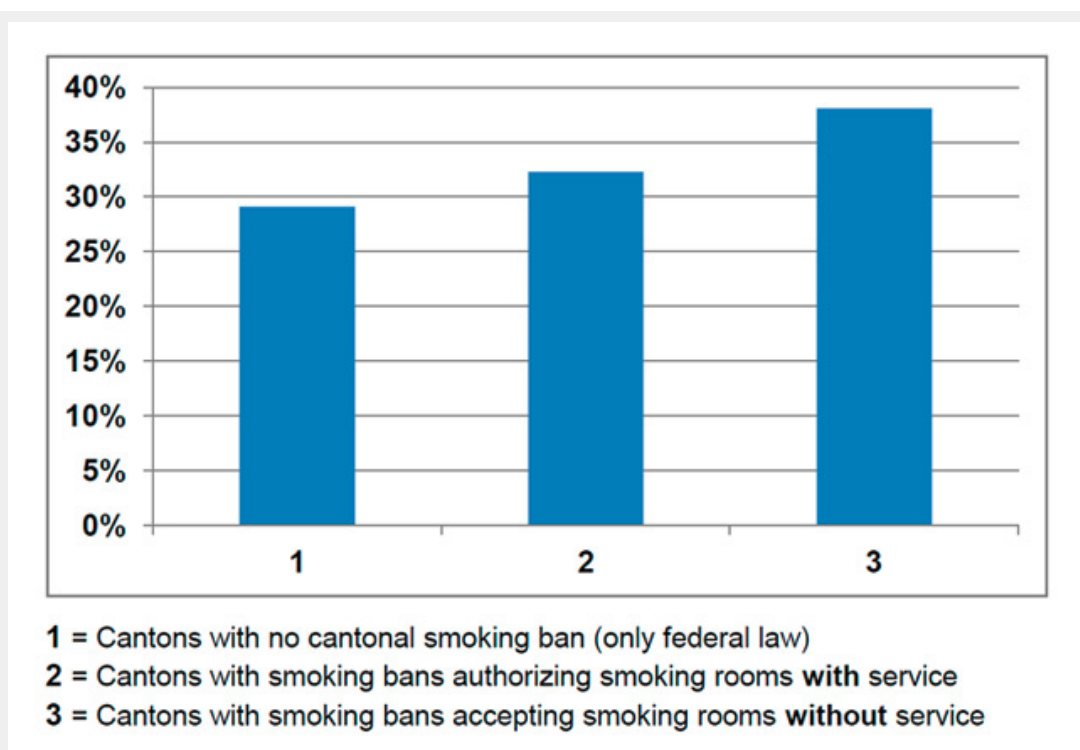
Figure 3 Result of the vote as a function of the current level of protection against exposure to second-hand tobacco smoke (percent of voters who have accepted the